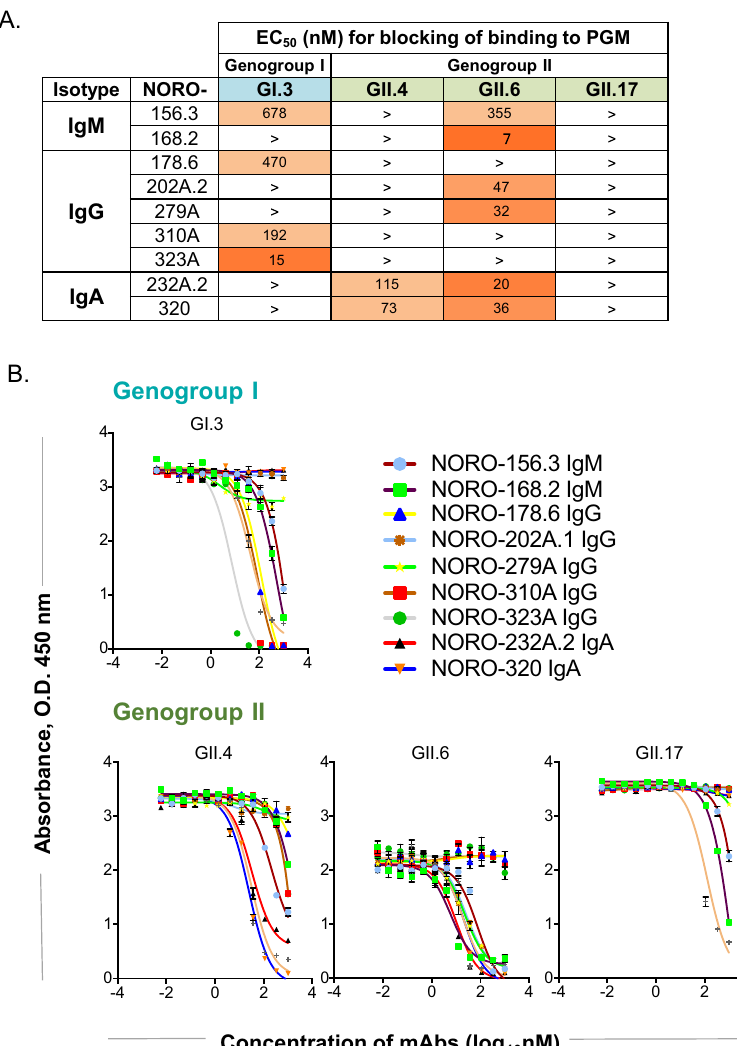
Fig. 2 Blocking activity of cross-reactive human mAbs for GI or GII VLPs. Blocking of VLP binding to PGM was used as a surrogate system to test neutralization of GI.3, GII.4, GII.6, or GII.17 VLPs using the indicated human mAbs. A Half-maximal effective concentrations (EC 50 ) for cross-reactive mAbs when blocking GI or GII VLPs from binding to PGM. EC 50 values were calculated using a sigmoidal dose-response nonlinear regression analysis after log transformation of the mAb concentrations using GraphPad Prism v 7.0 software. The > symbol indicates the blocking EC 50 value was greater than 1000 nM. B Blocking activity was tested using serial dilutions of each